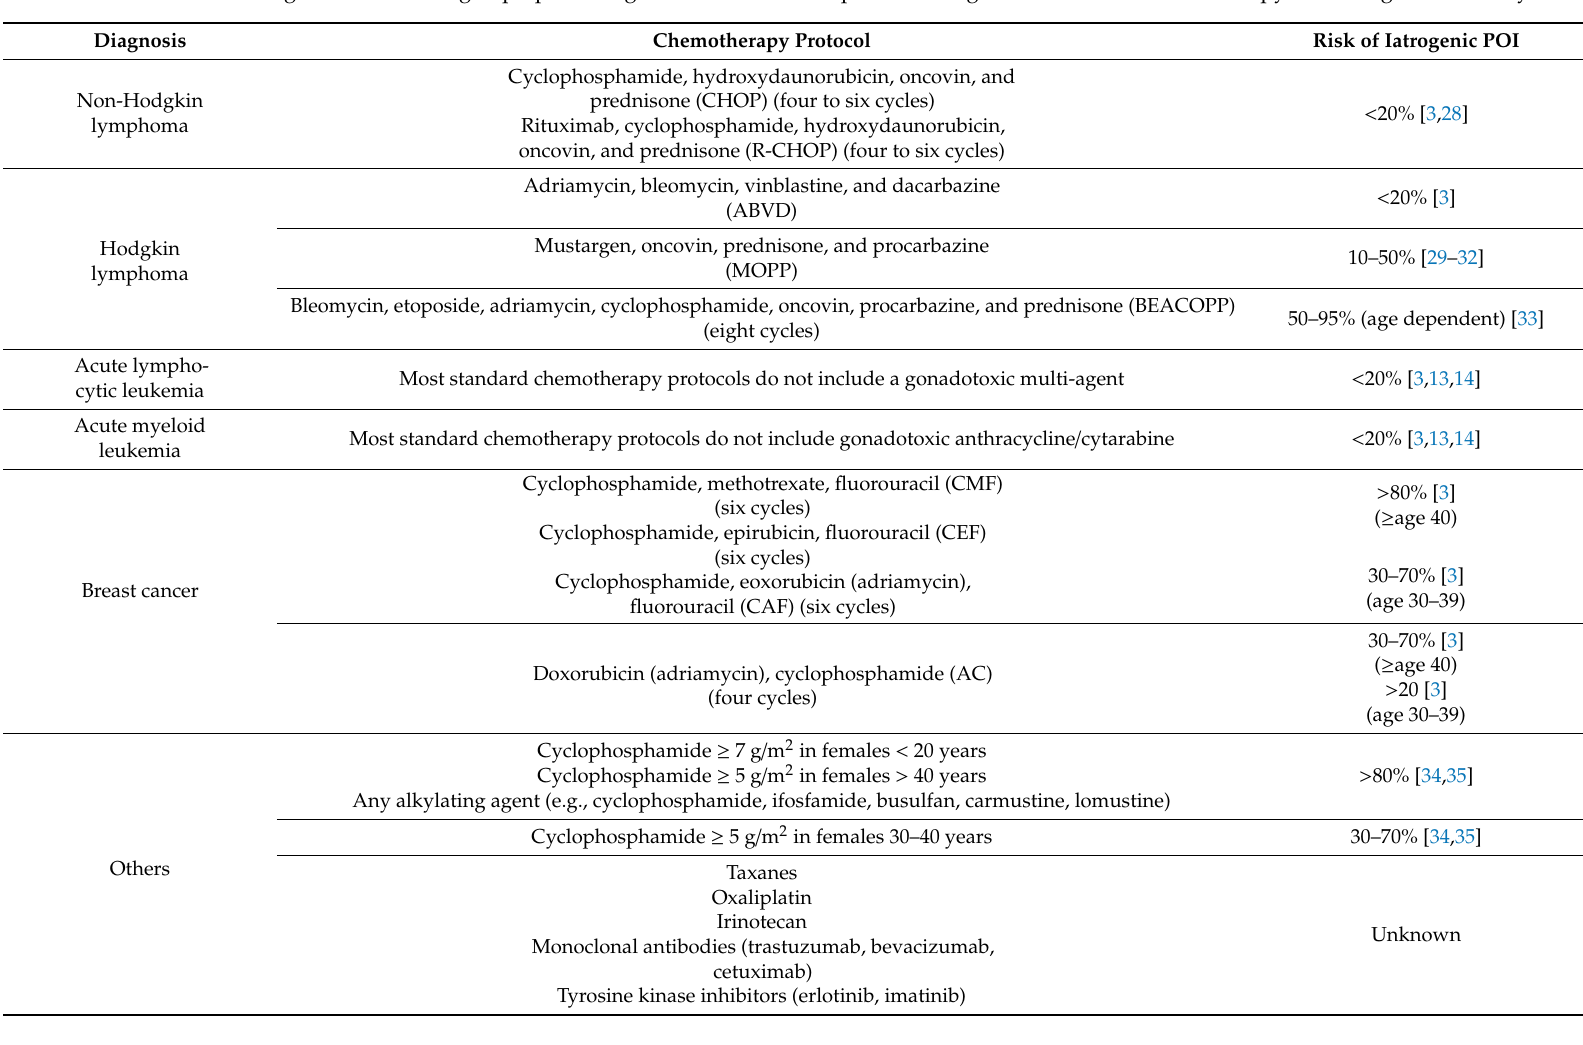
Table 1. Common malignancies occurring in prepubertal girls and women at reproductive age and the risk of chemotherapy-induced